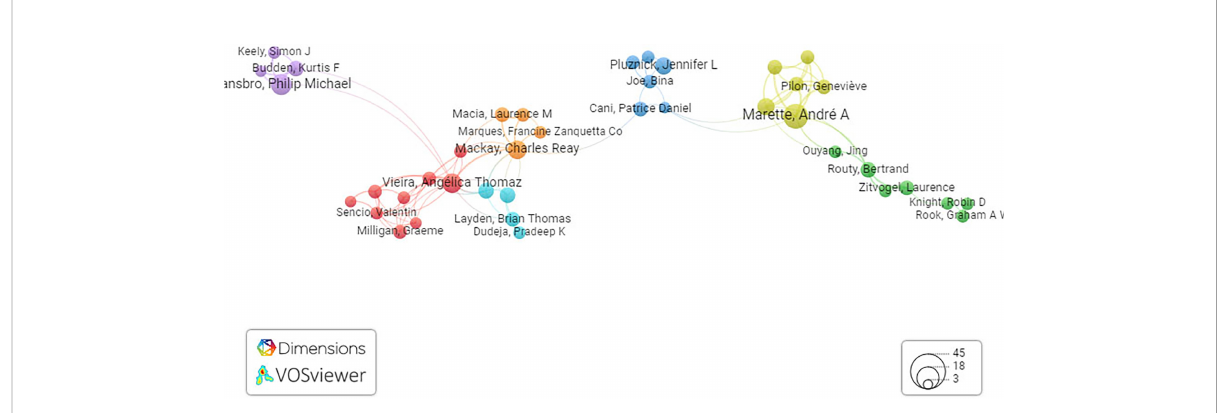
FIGURE 3 Network visualization map of co-cited references. Network visualization map of terms in published articles in literature related to the gut – lung axis and SCFAs collectively. The map shows four clusters represented in four different colors. Nodes with similar colors represent a cluster of related citations. The network map was generated using VOS viewer visualization